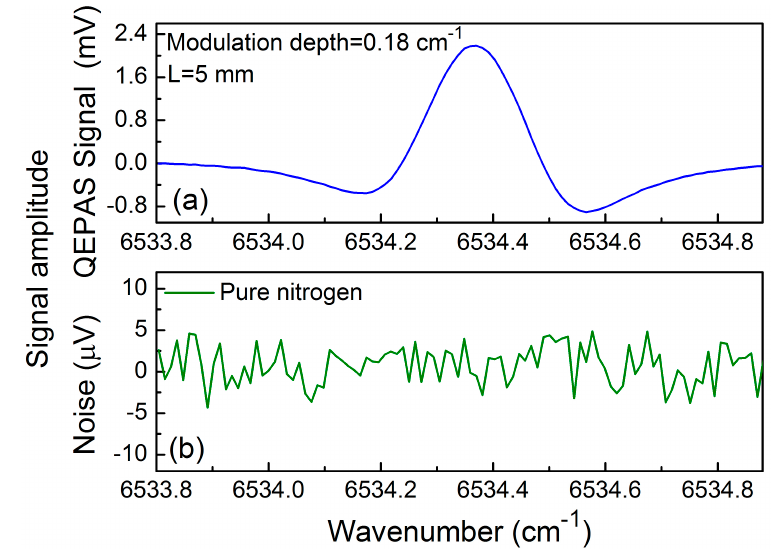
Figure 7. Signal amplitude: ( a ) 2 f C 2 H 2 -QEPAS signal using mR with L = 5 mm at a modulation depth of 0.18 cm − 1 ; ( b ) pure N 2 for noise determination.